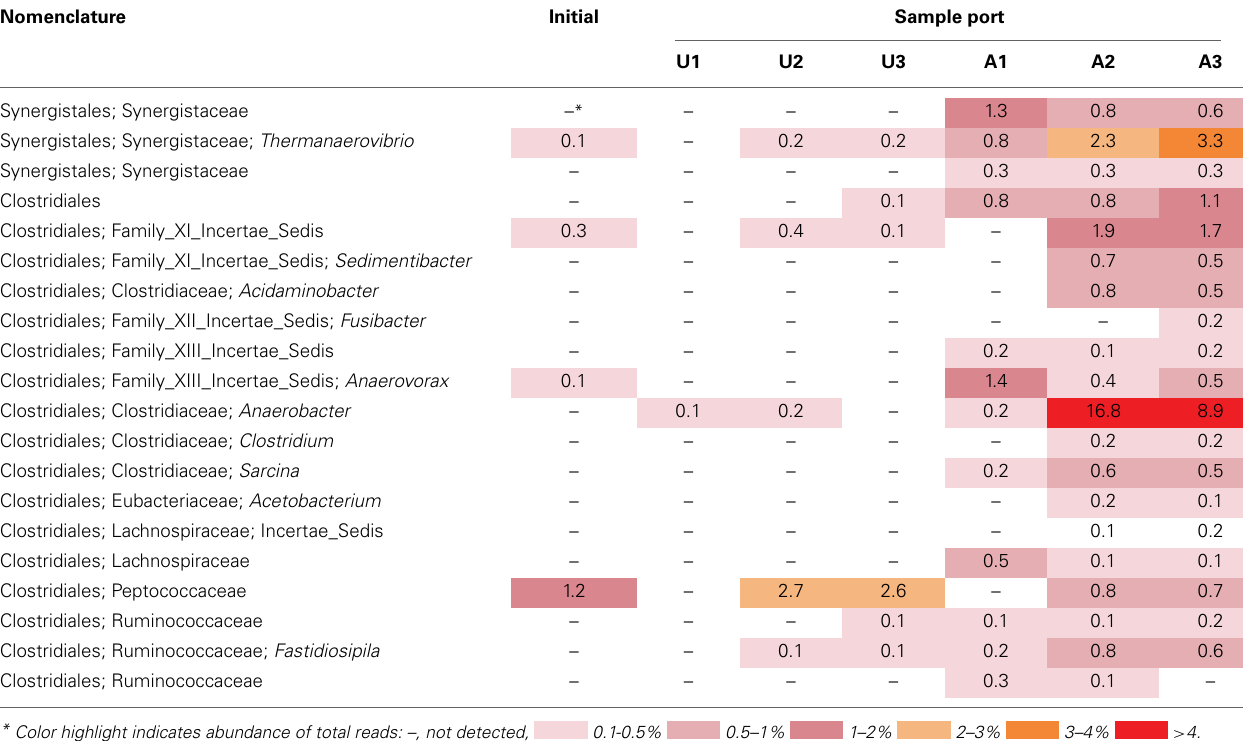
Table 4 | Relative abundance of 16S rRNA gene pyrosequences affiliated with the bacterial orders Clostridiales and Synergistales in MFT samples prior to amendment and in amended and unamended MFT after 213 days